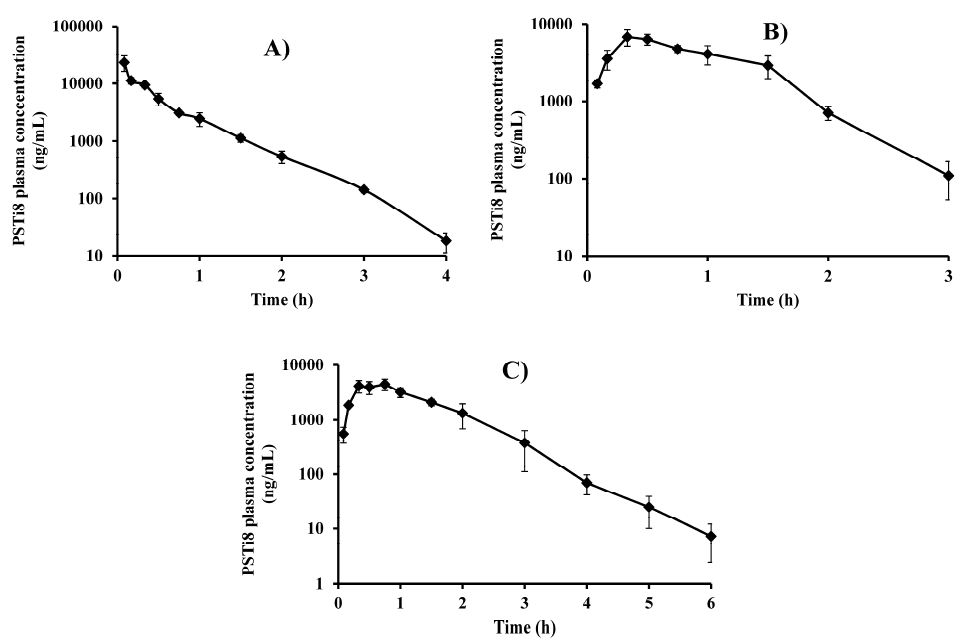
Figure 2. Pharmacokinetic studies of the PSTi8 peptide in different routes of administration in male SD rats. Plasma concentration against time profiles of the PSTi8 peptide at a dose of 5 mg/kg, after ( A ) i.v., ( B ) i.p. and ( C ) s.c. administration to each group. Data are represented in n = 6 with the mean ± SD. Table 2. Pharmacokinetic parameters of the PSTi8 peptide after i.v., i.p. and s.c. administration at 5 mg/kg in male SD rats. Data are presented as the mean ± SD with n = 6.